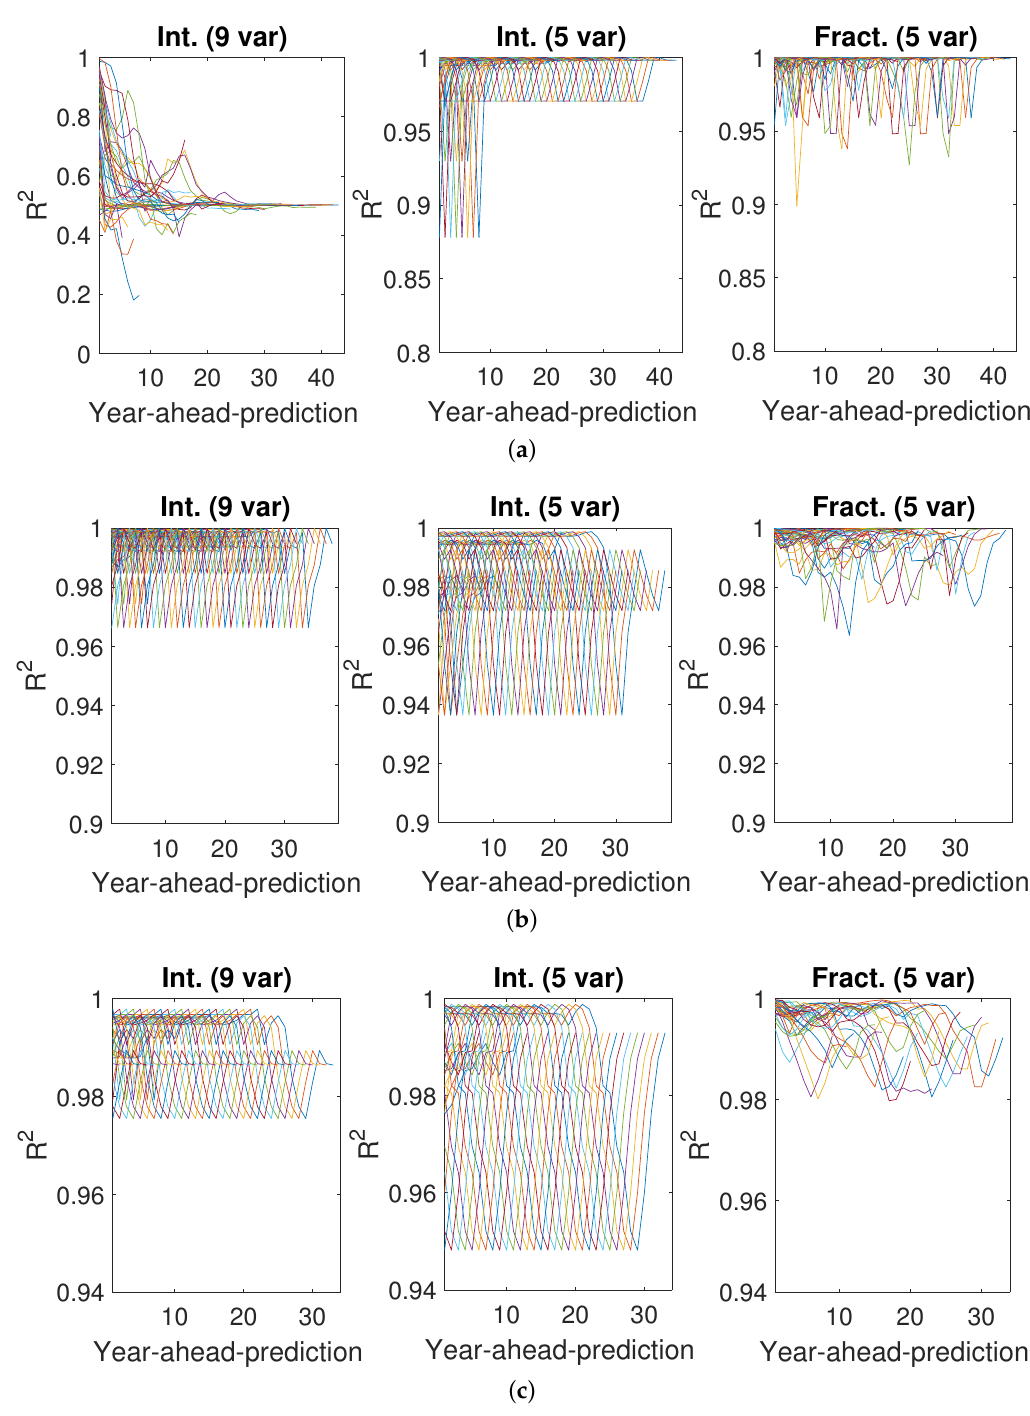
Figure 9. R 2 values of GDP estimates for the United States of America. Estimates were obtained with models (1) (left), (2) (middle), and (3) (right). The models were obtained with data for different numbers of years: ( a ) N = 5 (top) ( b ) N = 10 (center) ( c ) N = 15 (bottom). The models were used to estimate the GDP for as many years as possible after the period for which they were built. The scale of the y -axis is not the same for all models and all values of N